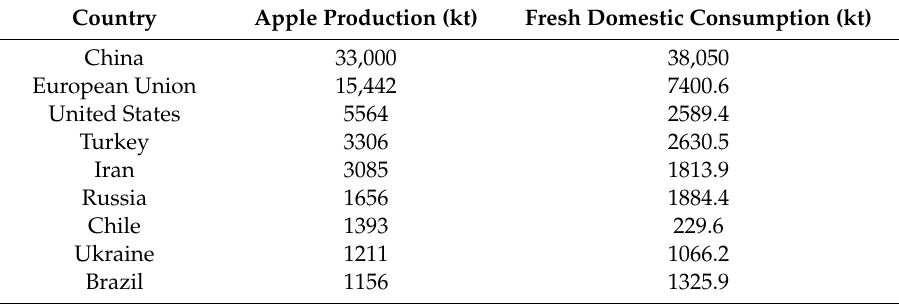
Table 1. Global production and consumption of fresh apples per year in 2019